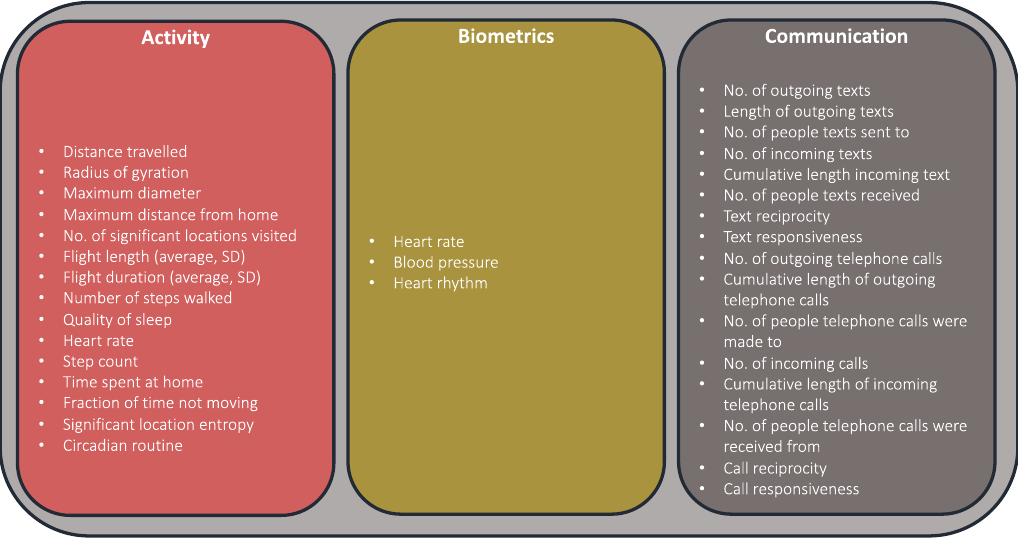
Figure 6. A Sankey-type flow diagram representing flow of studies by technology, data and function.